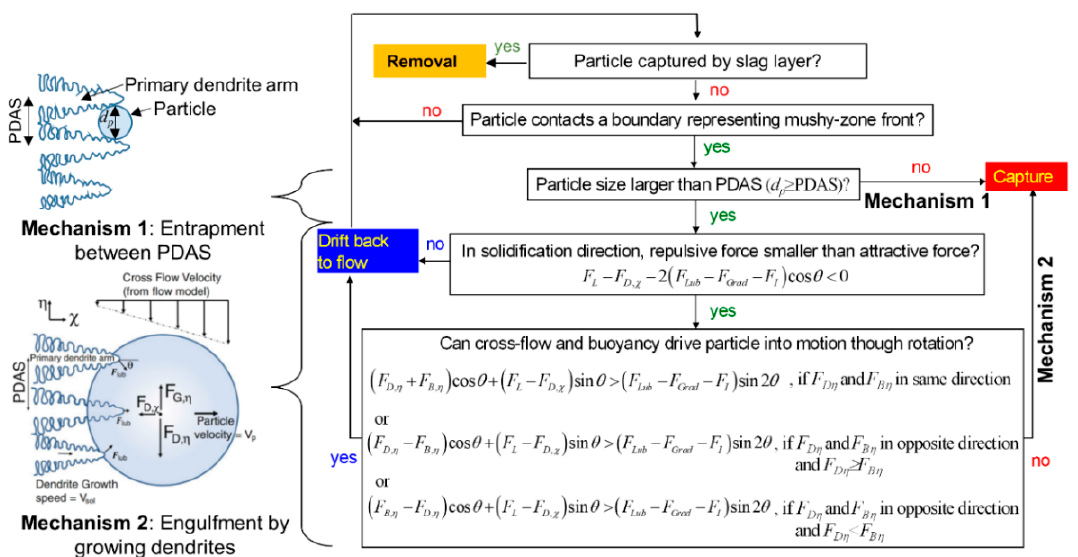
Figure 1. Flow chart of the advanced capture criterion modelling methodology.